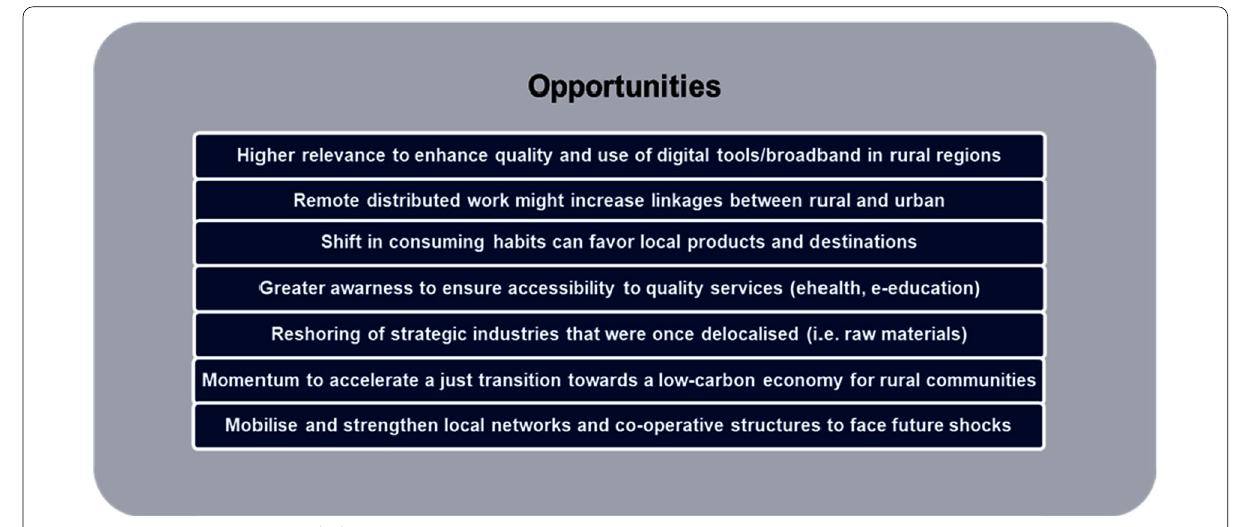
Fig. 4 Opportunities emerging with the COVID-19 crisis